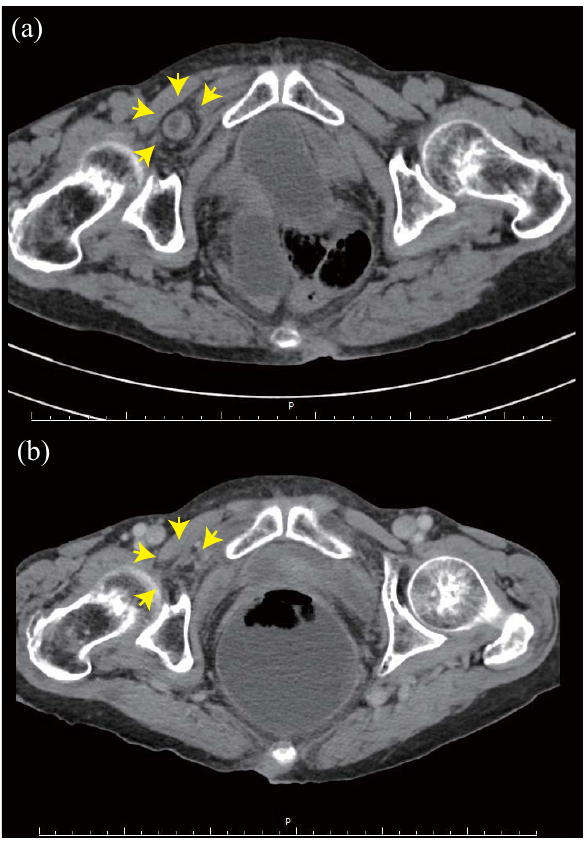
Figure 3. ( a ) Computed tomography showed an incarcerated small intestine (arrows) before manual reduction. ( b ) After reduction, the incarcerated small intestine disappeared